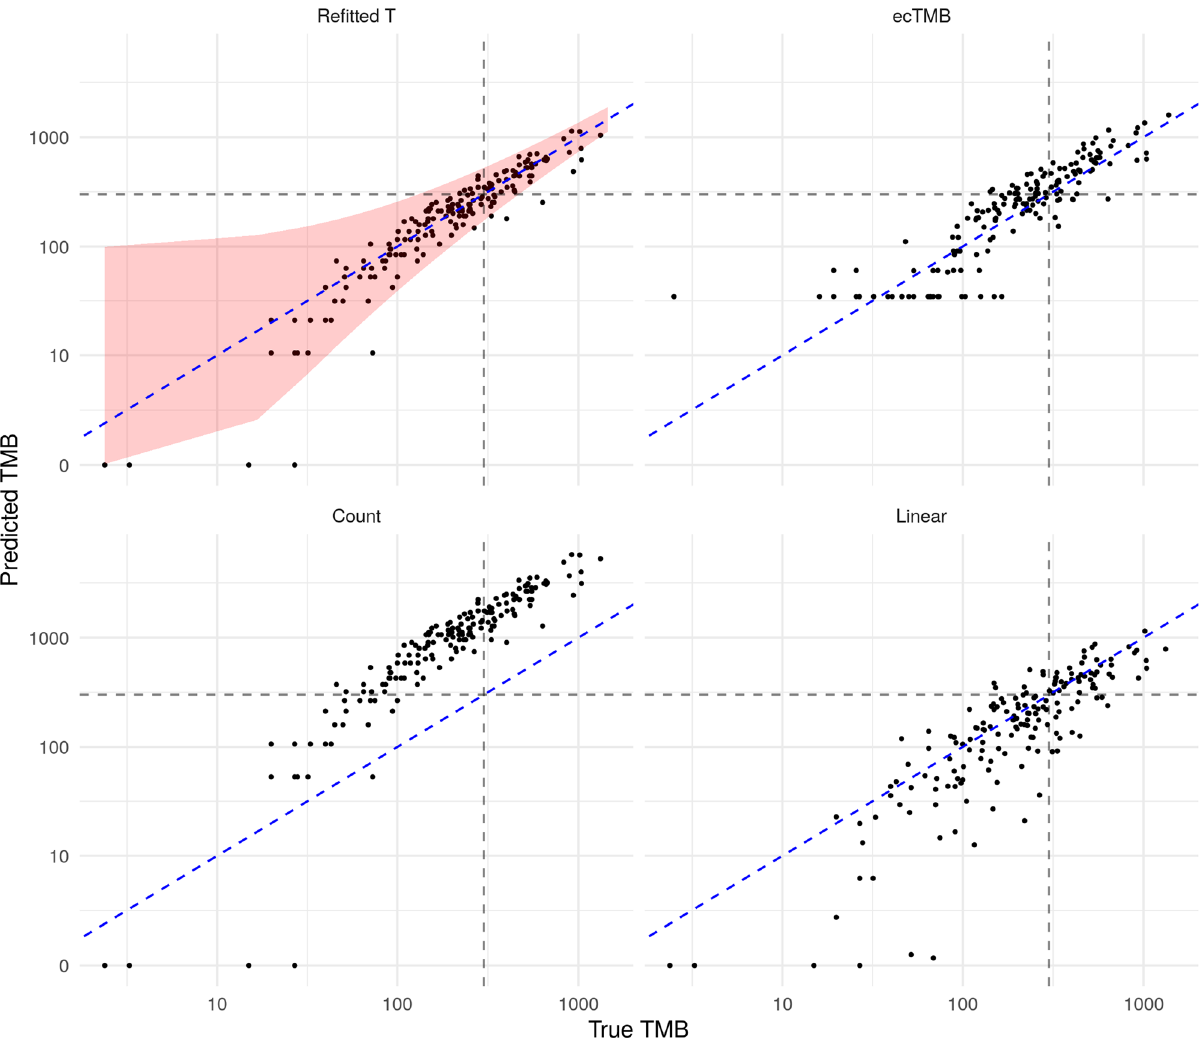
Fig. 4 Prediction of TMB on the test dataset. Dashed blue (diagonal) line represents perfect prediction and the black dashed lines indicate true and predicted TMB values of 300.